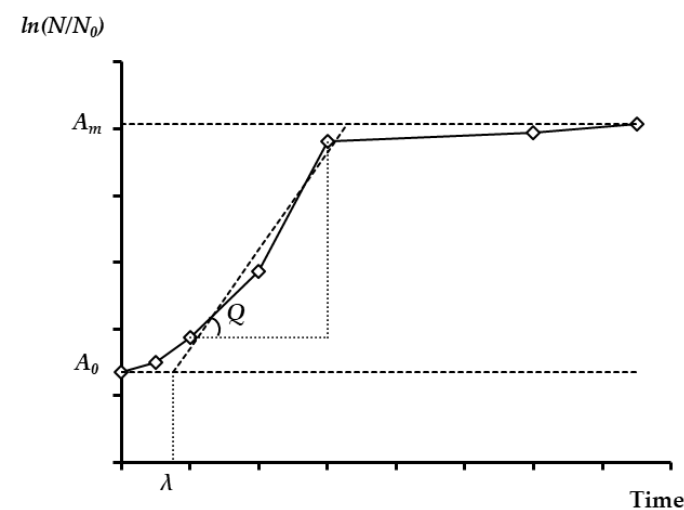
Figure 2. A growth curve, where A 0 is the lower asymptote, A m is the upper asymptote ( A m = ln N / N 0 ), Q is the maximum growth rate (g/L/h), lag-time ( λ ) is x -axis intercept of the tangent in the inflection point, ln ( N / N 0 ) is the logarithm of the relative population size.